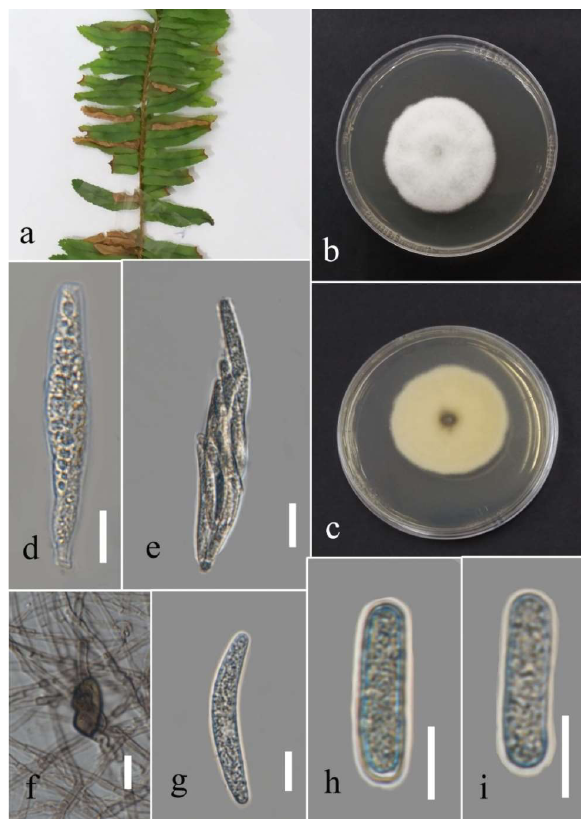
Figure 27. Morphology of Colletotrichum gigasporum (MFLUCC 22-0158): ( a ) leaf blight on Nephrolepis cordifolia ; ( b , c ) upper and reverse views of the culture after seven days of growth on PDA at 28 ◦ C; ( d ) immature ascus; ( e ) mature ascus; ( f ) appressorium; ( g ) ascospore; ( h , i ) Conidia. Scale bars ( d , e ) = 20 µ m and ( f – i ) = 10 µ